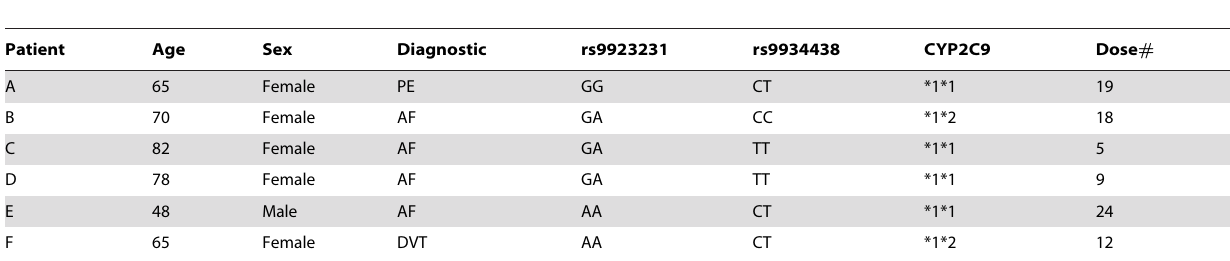
Table 3. Clinical characteristics and genetic profiles of 6 patients who lost the LD between VKORC1 polymorphisms rs2323991 and rs9934438.